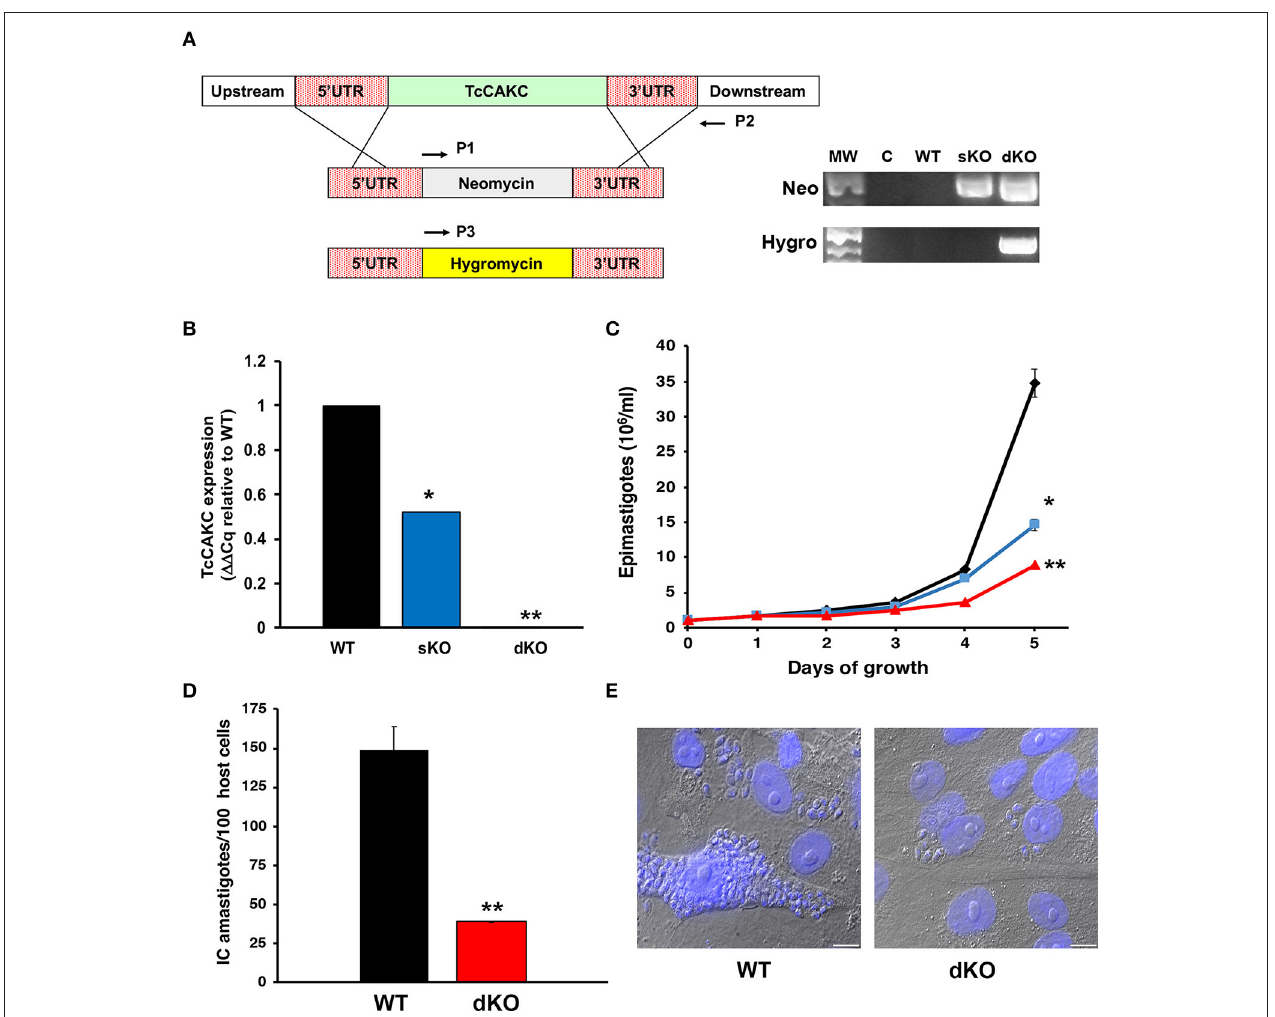
FIGURE 4 | Effect of TcCAKC knockout in T. cruzi fitness. (A) Schematic representation of the allelic replacement strategy for TcCAKC and genomic DNA screening showing the correct insertion of the drug resistance cassettes, screened with primers P1–P2 (neomycin) and P1–P3 (hygromycin). (B) qPCR analysis of TcCAKC expression levels in epimastigotes wild type (WT), one (sKO) or both (dKO) TcCAKC alleles replaced. Values are expressed as 11 Cq and normalized using GAPDH and tubulin as housekeeping genes. Mean ± SD of 3 independent experiments. * , ** p < 0.01 respect to WT. (C) Growth curve of epimastigotes WT (black), sKO (blue) and dKO (red). Mean ± SD of 3 independent experiments. * , ** p < 0.05 respect to WT at day 5 of growth. (D) Quantification of intracellular amastigotes comparing WT and dKO parasites at 48h post-infection. At least 100 host cells were counted in 4 coverslips per experiment, 3 independent experiments. Mean ± SD of